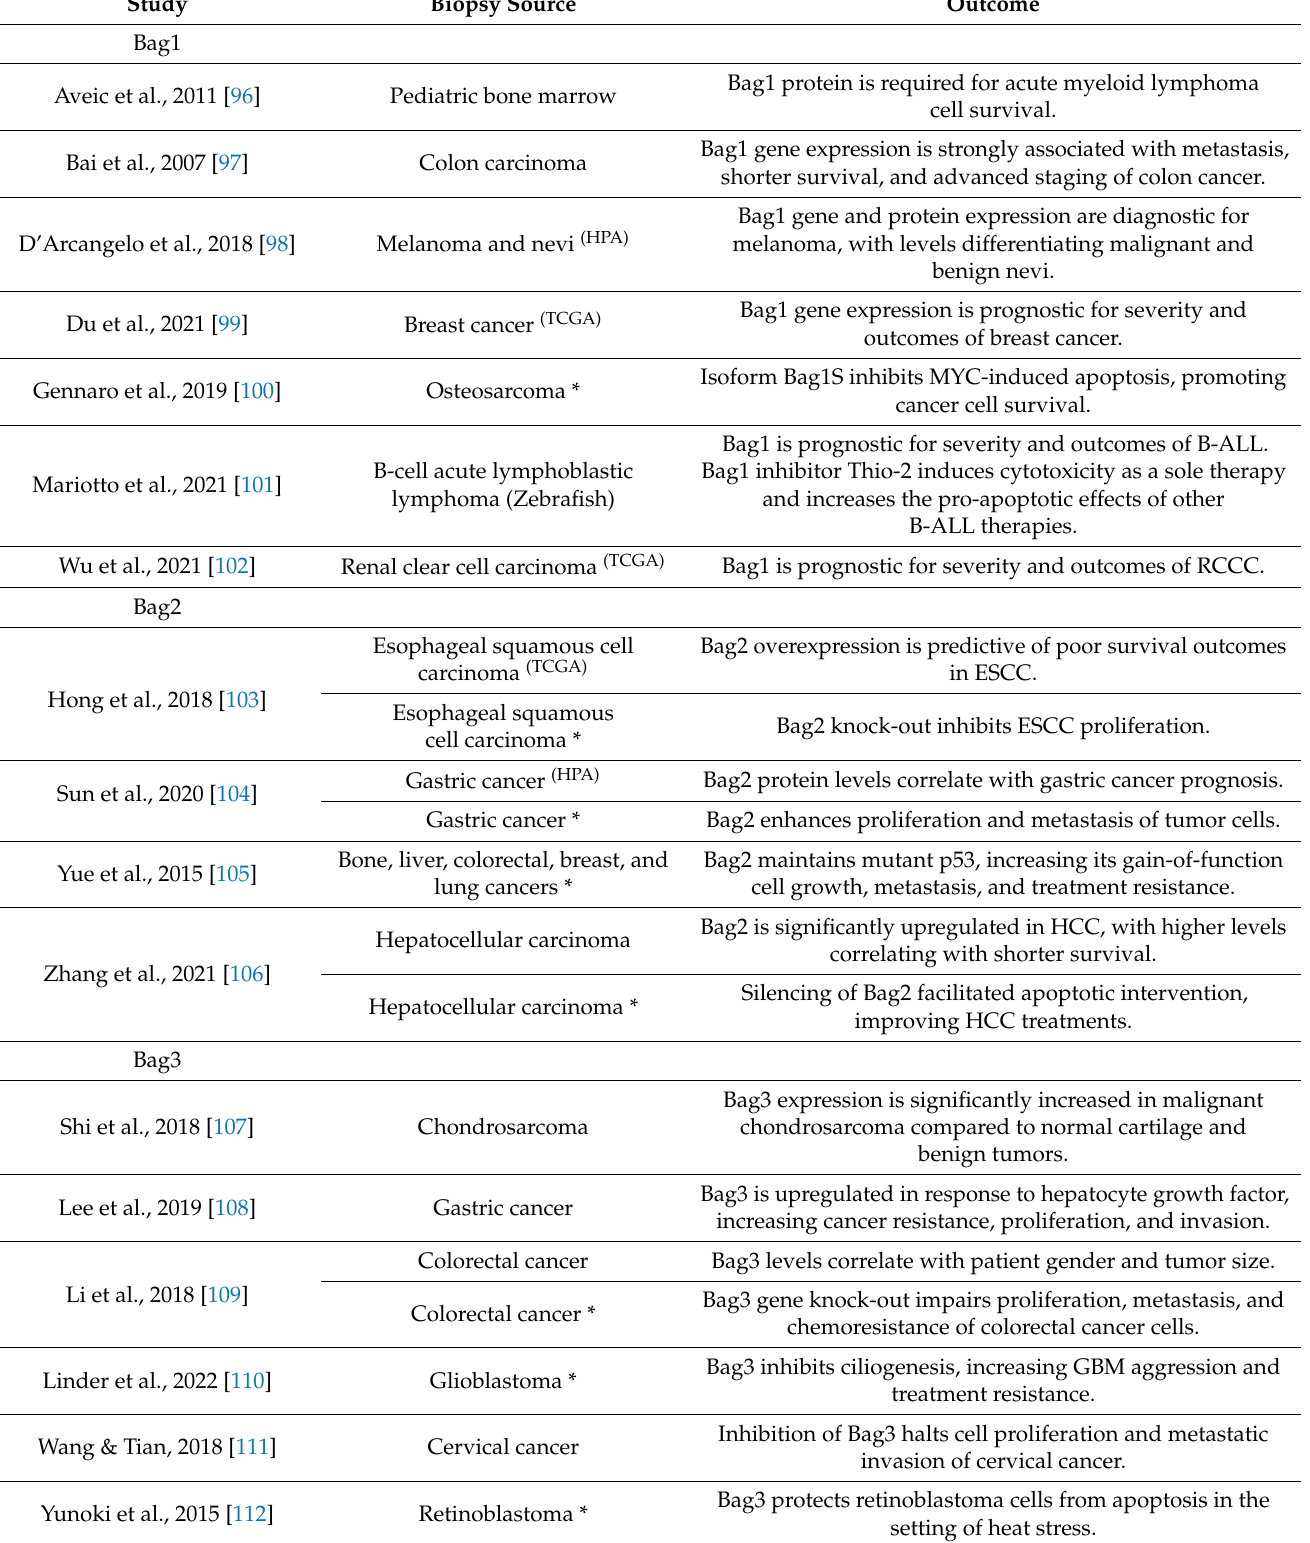
Table 2. Abnormal BAG gene and Bag protein levels that have been associated with